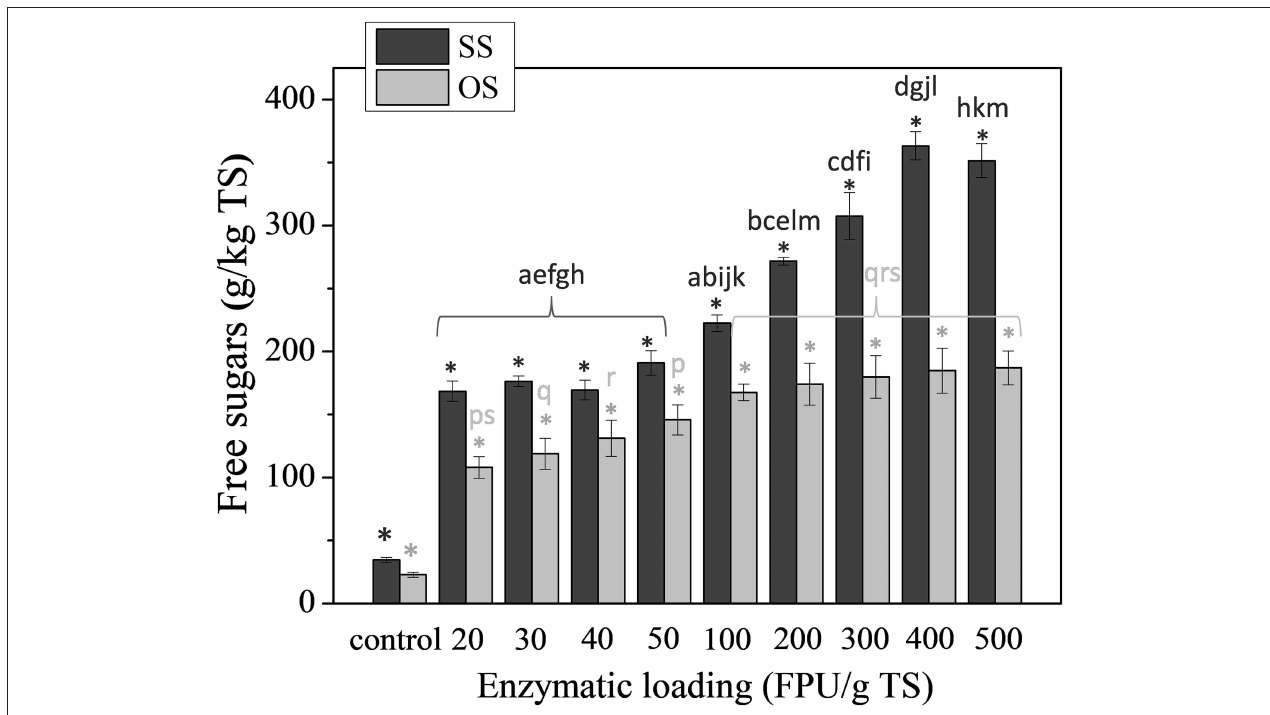
FIGURE 2 | The effect of enzymatic treatment at different enzyme concentrations (20–500 FPU/g TS) using the mixture of commercial enzymes, on the saccharification of carbohydrates of SS and OS. The results are mean ± SD from six different measurements ( N = 6). The statistical difference with the control (untreated biomass) is indicated by an asterisk above columns, whereas statistical difference among values is indicated by different letters above columns (Mann Whitney u